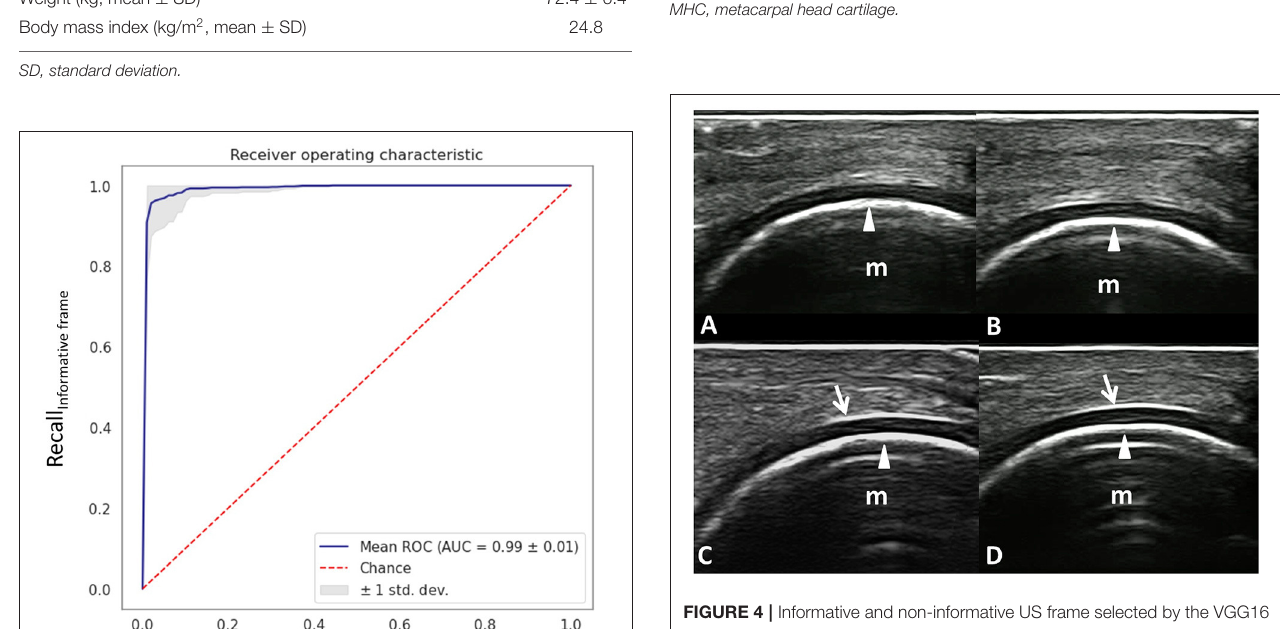
FIGURE 4 | Informative and non-informative US frame selected by the VGG16 CNN algorithm “MHC identifier 1.” Dorsal longitudinal scans acquired at the metacarpal head level in healthy subjects. (A,B) Examples of non-informative frames; (C,D) Examples of informative frames. In fact, while the inner margin (arrowheads) is evident in all the panels, the chondrosynovial (arrows) interface is clearly visible only in the lower images (C,D) . m, metacarpal head; arrows, chondrosynovial interface; arrowheads, osteochondral